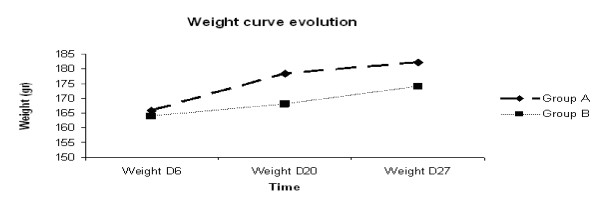
Evolution of the weight median depending on time of observation according to the group.